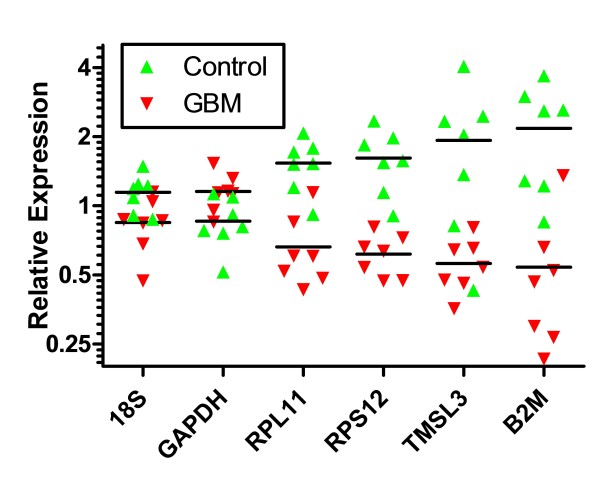
Validation by qRT-PCR of down-regulated genes. Gene expression levels were normalized to the combined expression of GAPDH and 18S. Lines represent median values for the GBM and control samples, respectively.